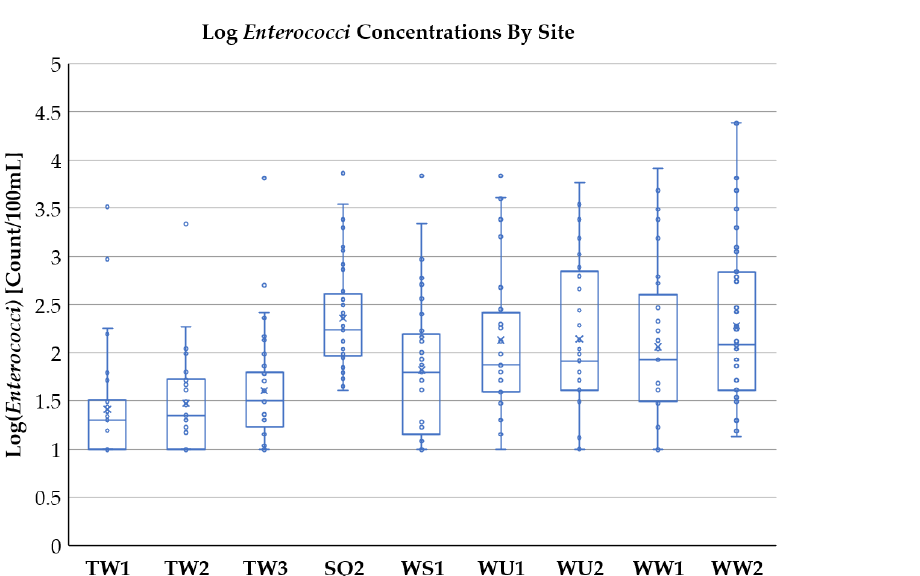
Figure A2. FIB: Box plots for Enterococci concentrations based on site.